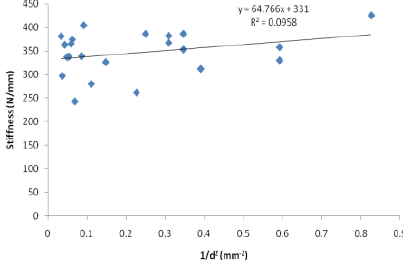
Figure 4: : 1/depth 2 against stiffness for specimens produced form the diaphysis of two bovine femurs. Linear regression gives a characteristic length of 0.15mm and micropolar Young’s modulus of